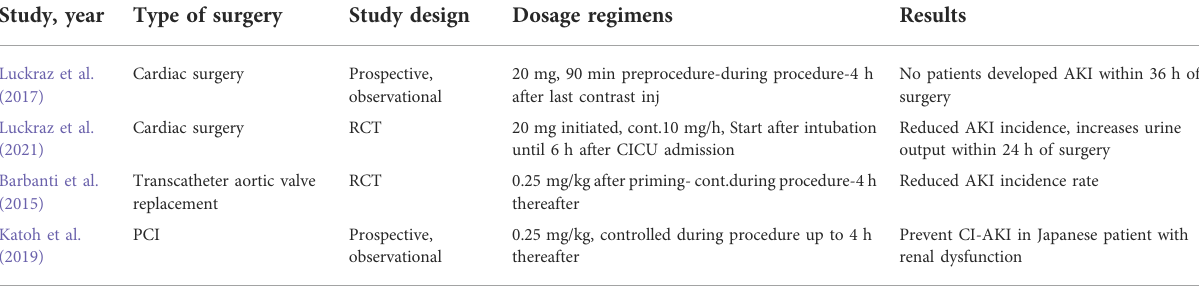
TABLE 1 Evidences of renal guard system utilization for AKI